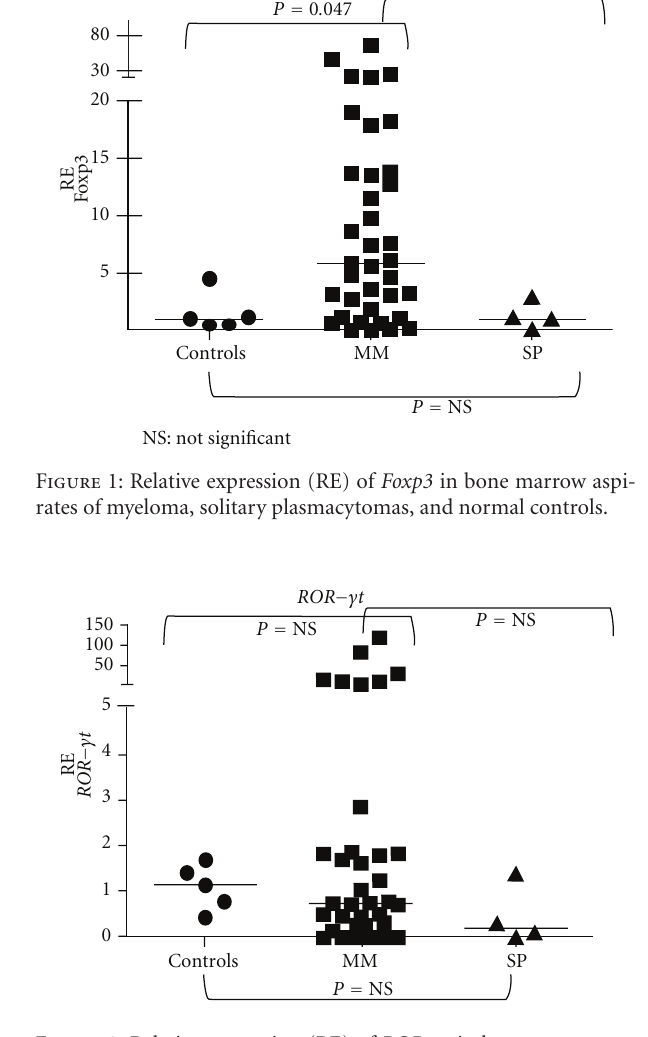
Figure 2: Relative expression (RE) of ROR- γ t in bone marrow as- pirates of myeloma, solitary plasmacytomas, and normal